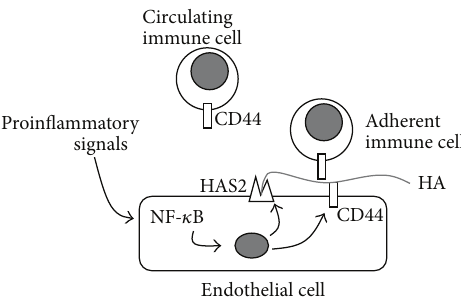
Figure1:SchematicrepresentationoftheregulationofHAsynthesis in ECs and the effects on immune cell-EC adhesion. Through their receptors, proinflammatory signals (i.e., cytokines) trigger NF- 𝜅 B pathway that regulates both HAS2 and CD44 (and other adhesive molecules such as ICAM-1, E-selectin, VCAM-1, and MHC class I genes) [38]. HAS2 synthesizes high molecular weight HA that interacts with CD44 present on both ECs and immune cells (i.e., leukocytes) in the “sandwich model,” which drives immune cells to adhere to ECs contributing to inflammation. Gray circle represents the nucleus.